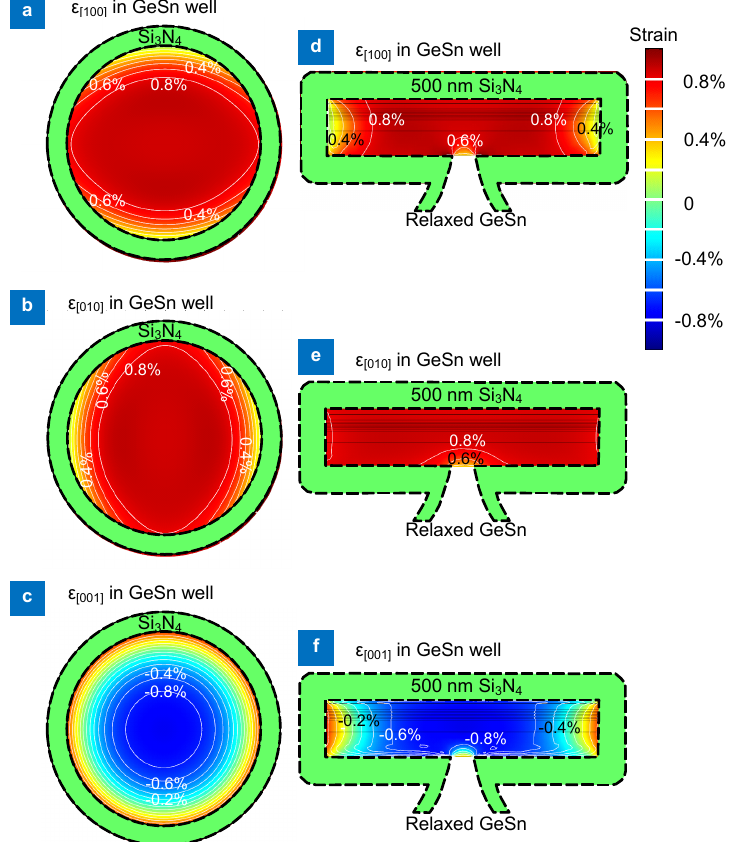
Fig. 8 | Contour plots for ( a ) ε [100] , ( b ) ε [010] , and ( c ) ε [001] in the normal cross section plane and ( d ) ε [100] , ( e ) ε [010] , and ( f ) ε [001] in the radial cross section plane in GeSn well for the Ge 0.90 Sn 0.10 /Si 0.161 Ge 0.695 Sn 0.144 MQW laser wrapped in a 500 nm Si 3 N 4 liner stressor . Figure reproduced from ref. 36 ,